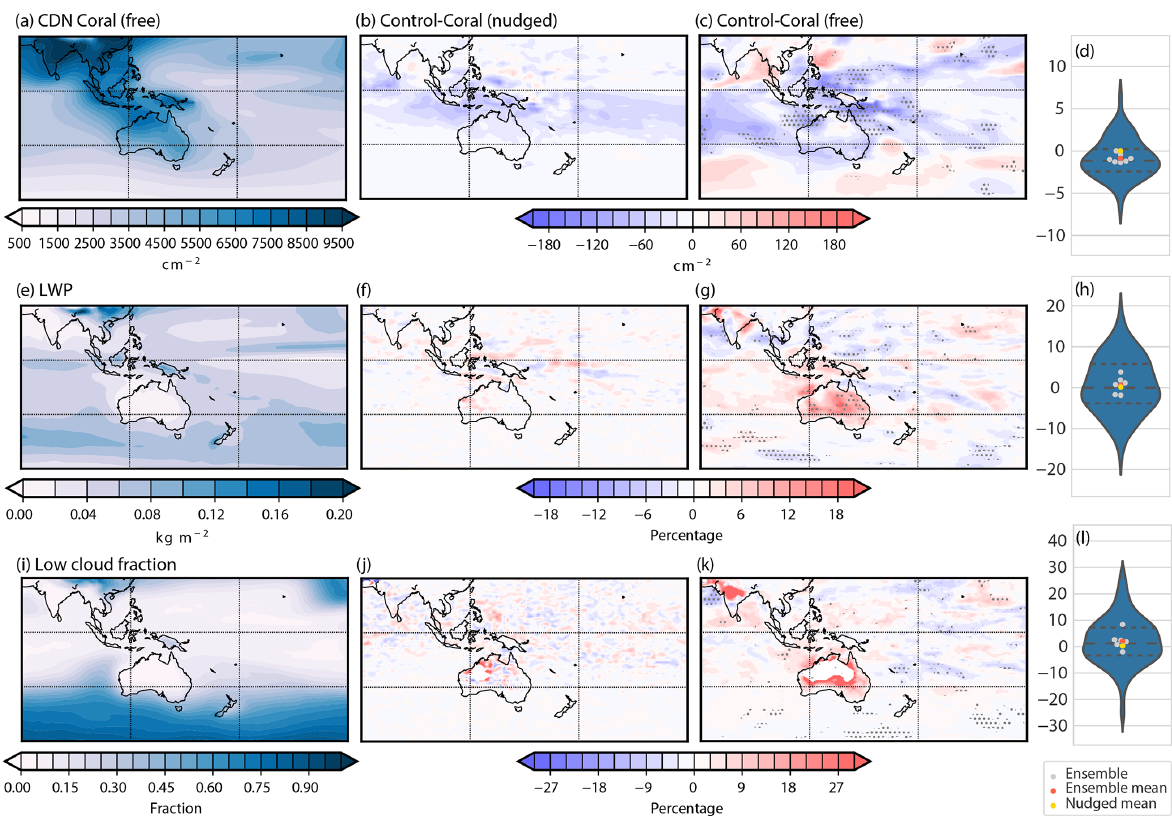
Figure 11. As for Fig. 9 but for column integrals of CDN (first row) in square centimetres (cm − 2 ), LWP (second row) in kilograms per square metre (kgm − 2 ) and percent and low cloud fraction (third row) as a fraction and in